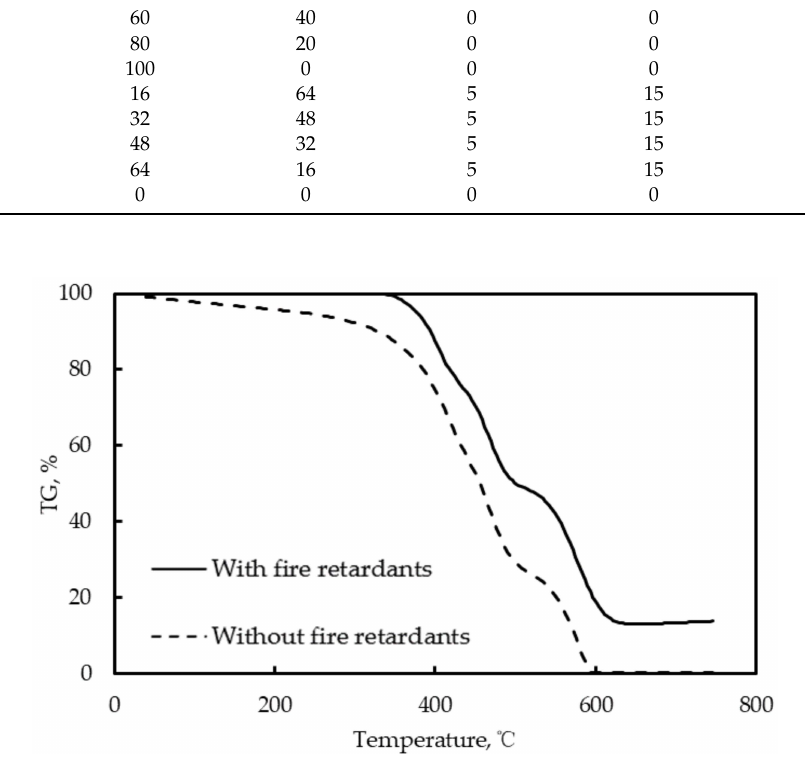
Figure 4. Typical TG curve of the asphalt with or without fire